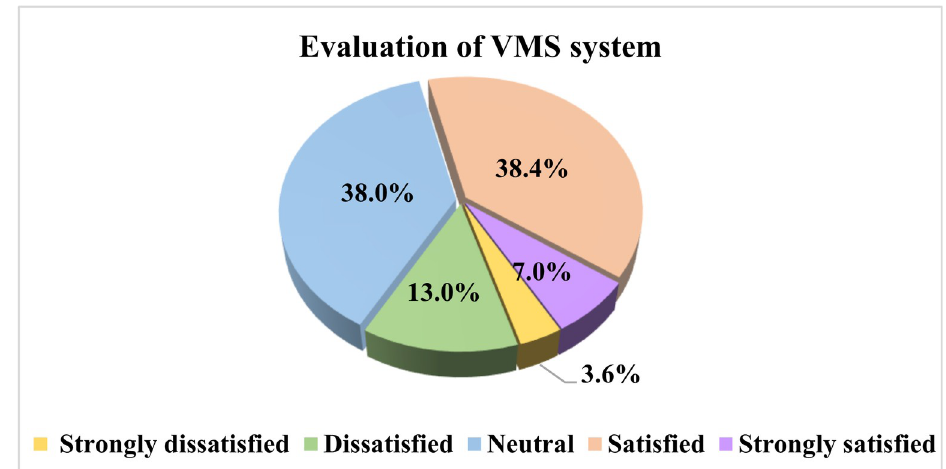
Fig 3. Proportional distribution of perceived quality of service.